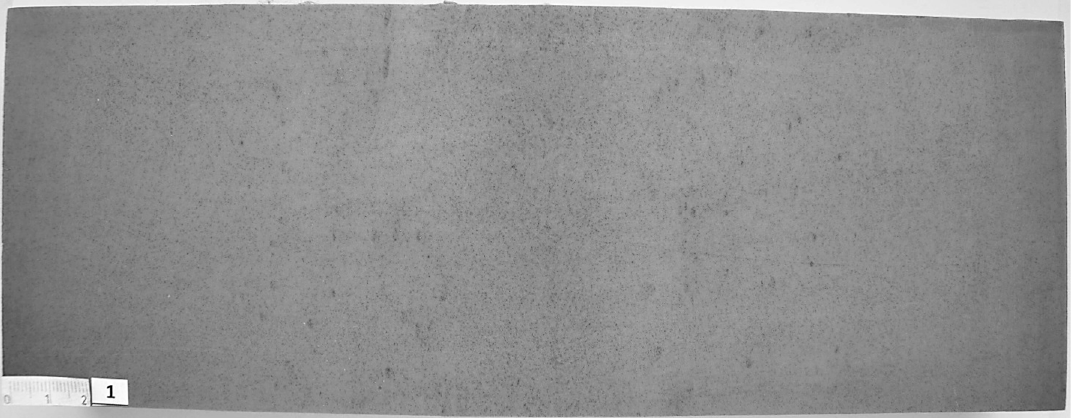
Figure 8. Central segregation in macrostructure of sample 1.